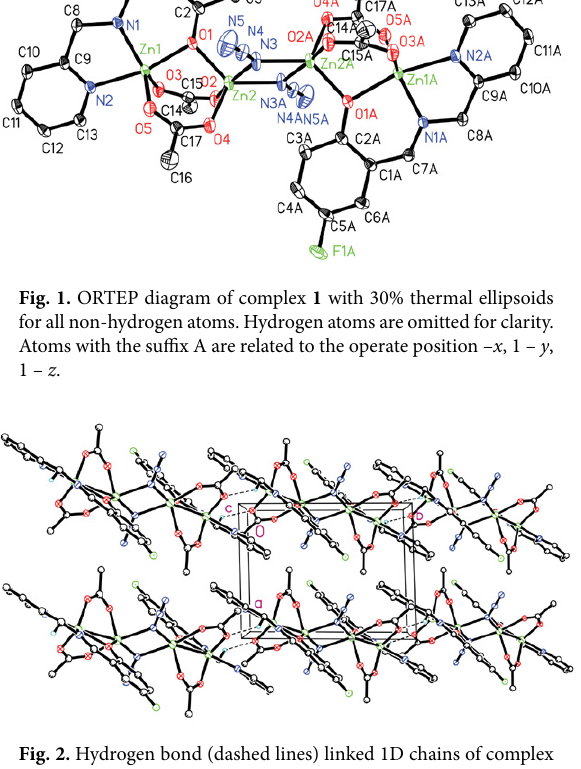
Fig. 2. Hydrogen bond (dashed lines) linked 1D chains of complex 1 , viewed along the c axis.